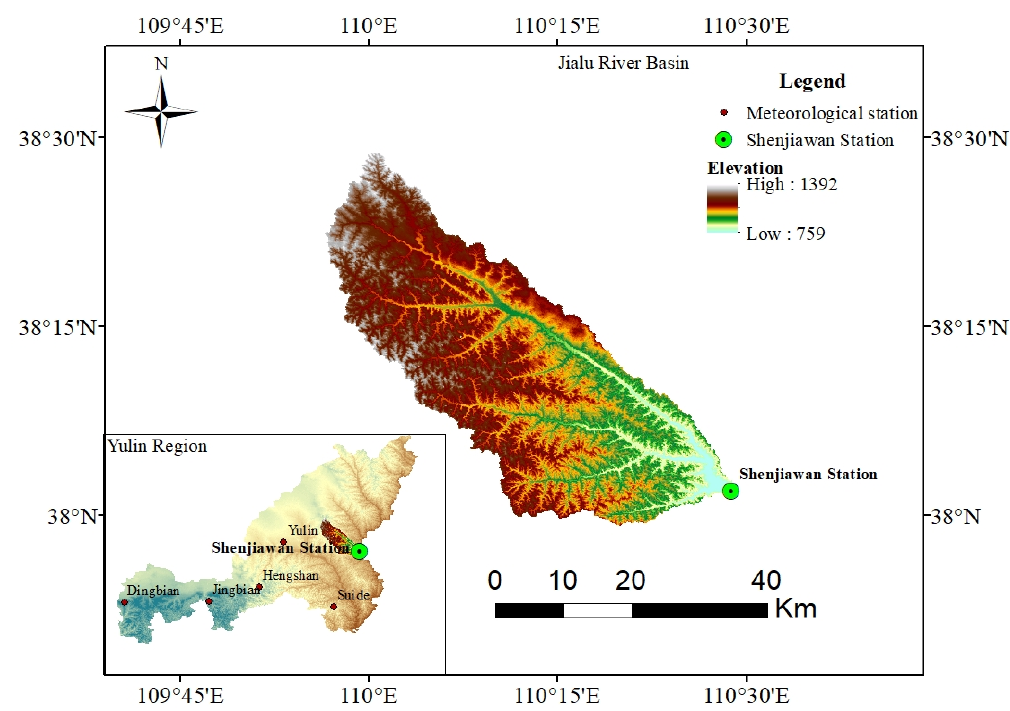
Figure 2. Geographic location of the JRB and meteorological and hydrological data.